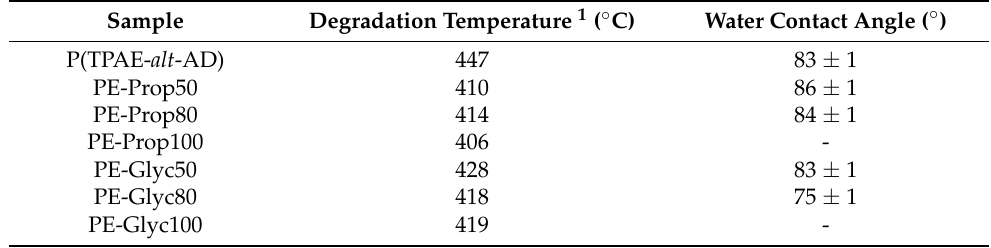
Figure 6. TGA curves of ( a ) P(TPAE- alt -AD) (black dot-dashed line), PE-Prop50 (red dashed line), PE-Prop80 (olive short dashed line), and PE-Prop100 (blue solid line); ( b ) P(TPAE- alt -AD) (black dot-dashed line), PE-Glyc50 (red dashed line), PE-Glyc80 (olive short dashed line), and PE-Glyc100 (blue solid line). Table 2. Degradation temperature of the functional polyesters and WCAs on thin polymer